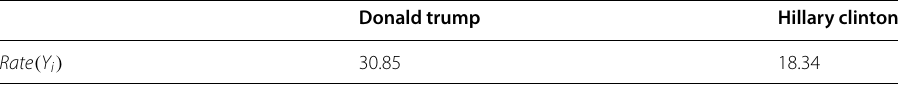
Table 7 US Presidential election